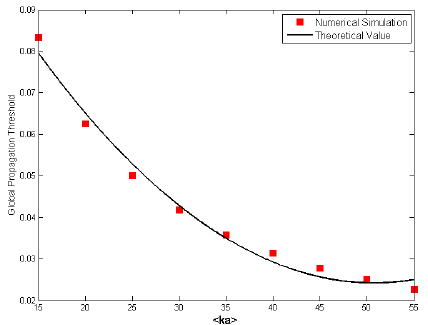
Figure 5. Global spreading thresholds and its simulation fitting.